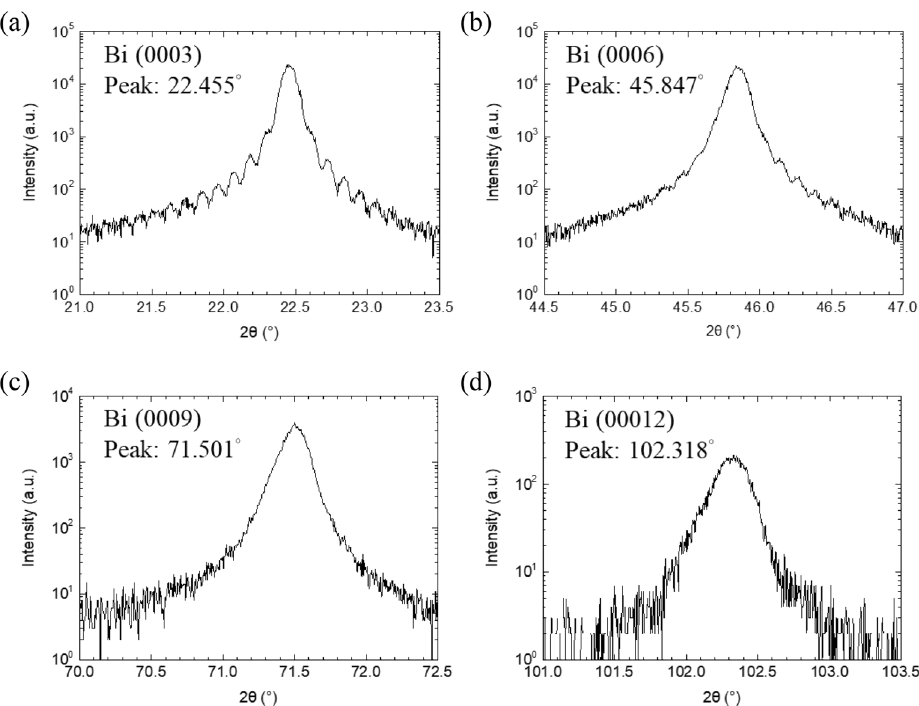
Figure 5. HRXRD ω-2θ scan results of ( a ) Bi(0003), ( b ) Bi(0006), ( c ) Bi(0009), ( d ) Bi(00012)